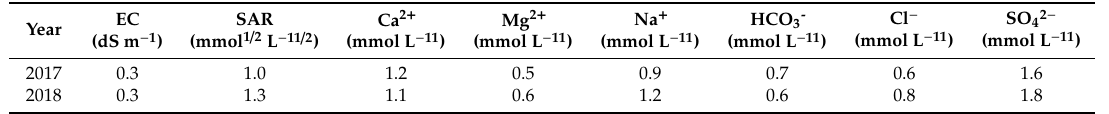
Table 1. Average quality of irrigation water during 2017 and 2018